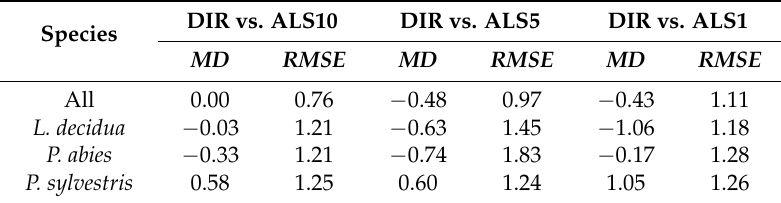
Table 5. Mean difference (MD) and Root mean square error ( RMSE ) between field direct (DIR) and ALS data for the whole dataset (All) and divided by species. ALS data are presented divided by pulse densities (10, 5, 1 points/m 2 ) obtained through point cloud